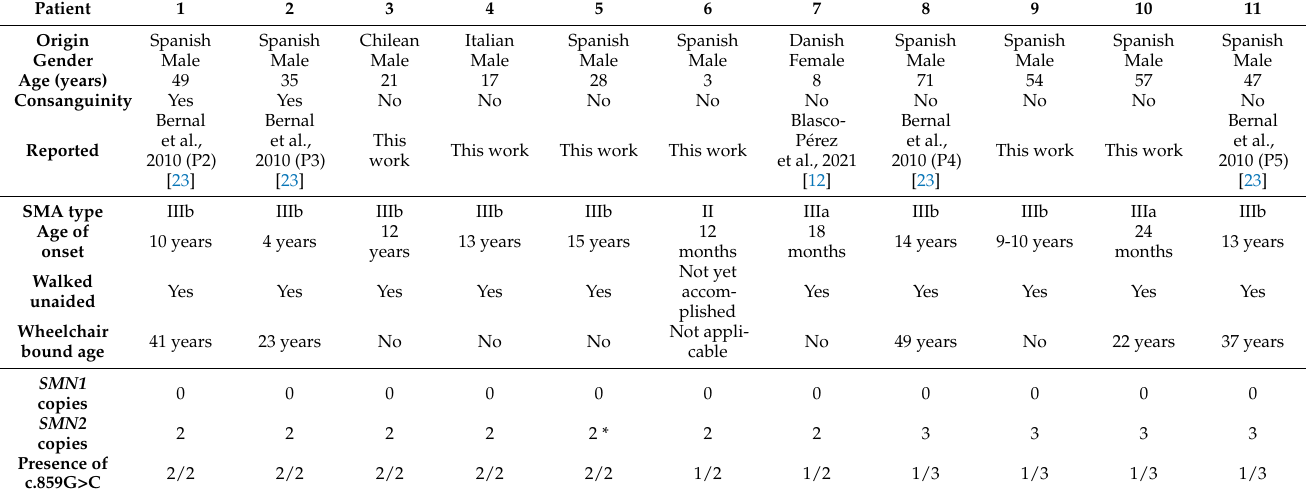
Table 1. Clinical and molecular data of patients. Information regarding general characteristics of patients, SMA phenotype, and SMN1/2